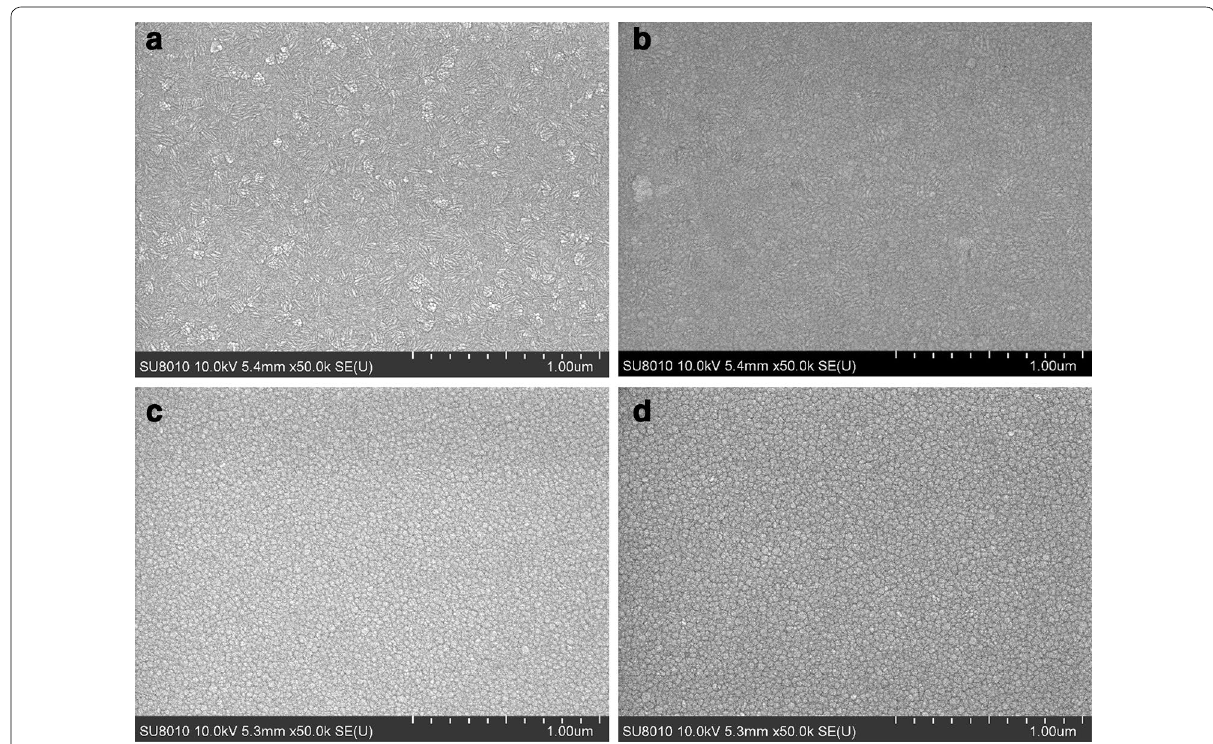
Fig. 5 FESEM observations of ITO layers by sputtering with reused ITO target dependent on film thickness; a 130 nm, b 180 nm, c 250 nm, and d 350